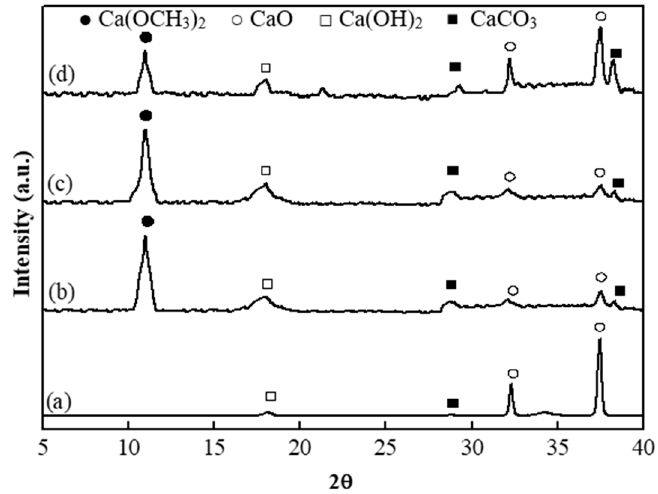
Figure 2. XRD patterns of (a) commercial CaO, (b) Ca(OCH 3 ) 2 synthesized for 2 h using conventional water-bath heating, and Ca(OCH 3 ) 2 synthesized using a homogenizer for (c) 60 min and (d) 30 min.